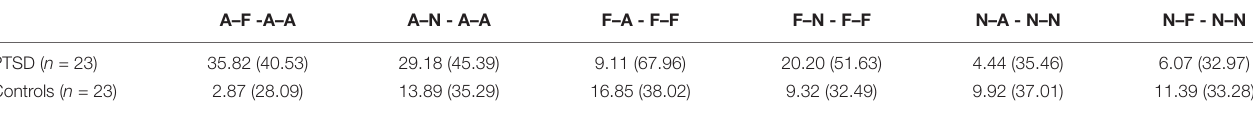
TABLE 4 | Reaction time congruency effects.